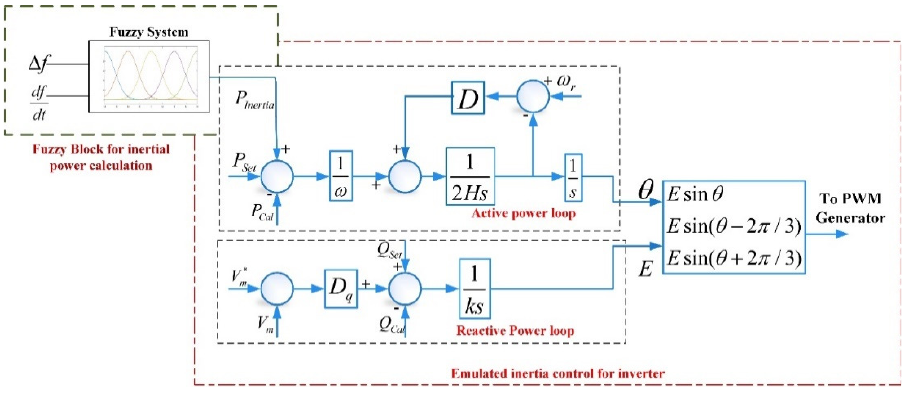
Figure 9. Fuzzy logic-based emulated inertia